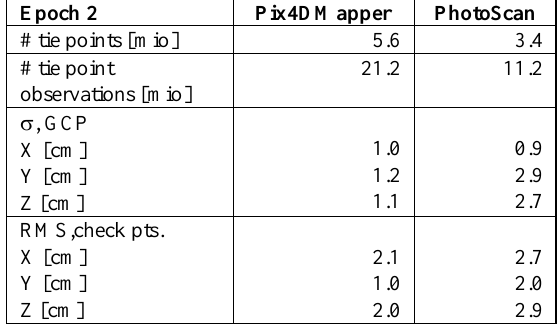
Table 2: Results of bundle adjustment, different software packages